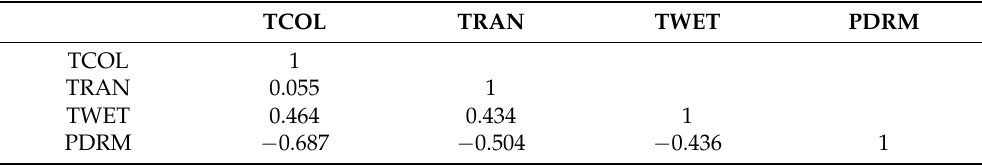
Table A1. Correlation between environmental variables (Pearson). TCOL, min temperature of coldest month; TRAN, temperature annual range; TWET, temperature of wettest quarter; PDRM, precipitation of the driest month.